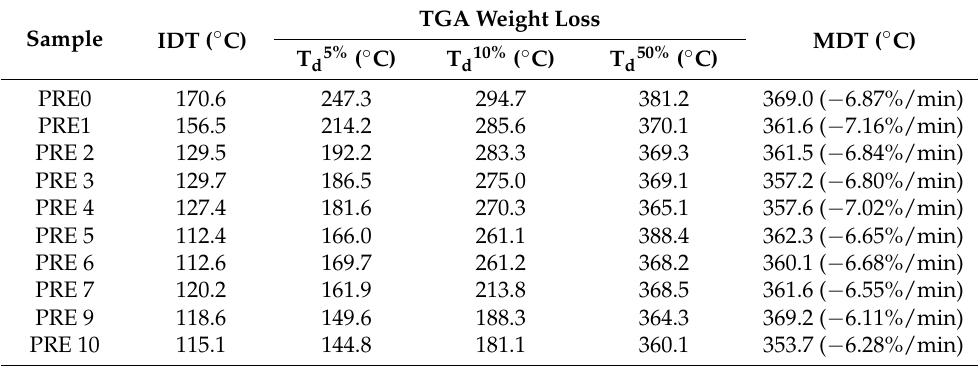
Table 1. Effect of eugenol content on the thermal properties of cured urethane